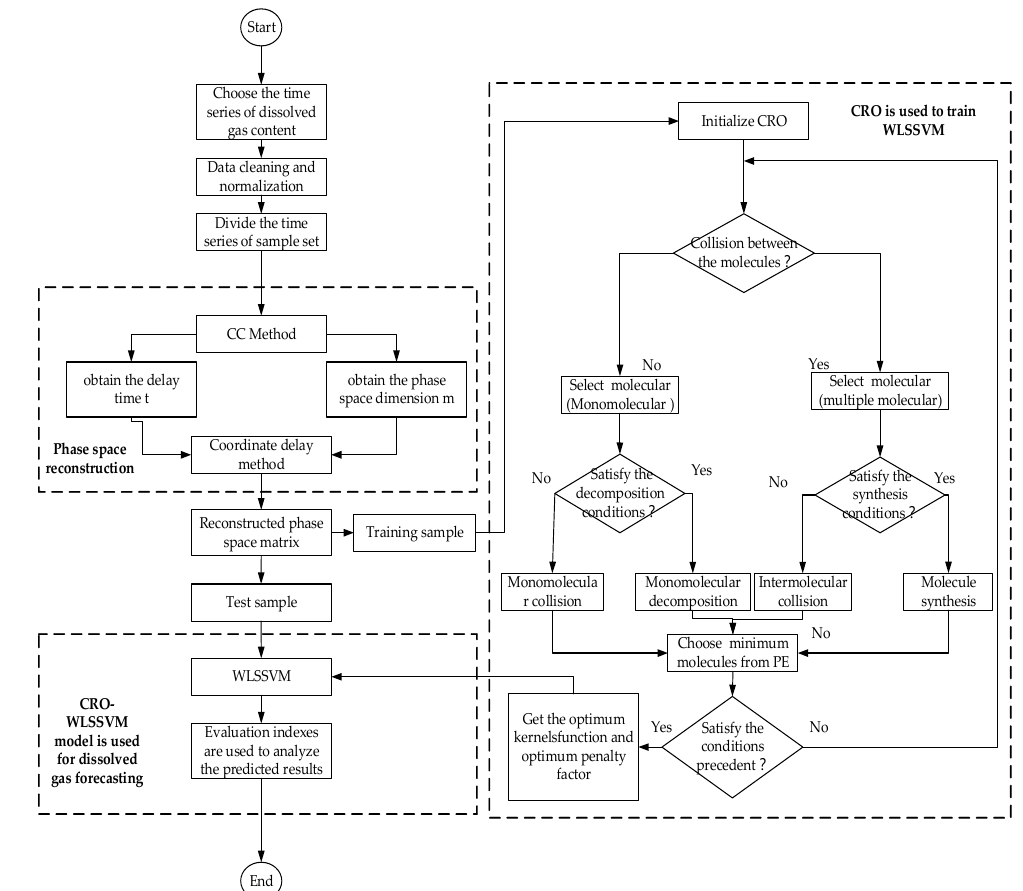
Figure 2. Construction process of PSR-CRO-WLSSVM